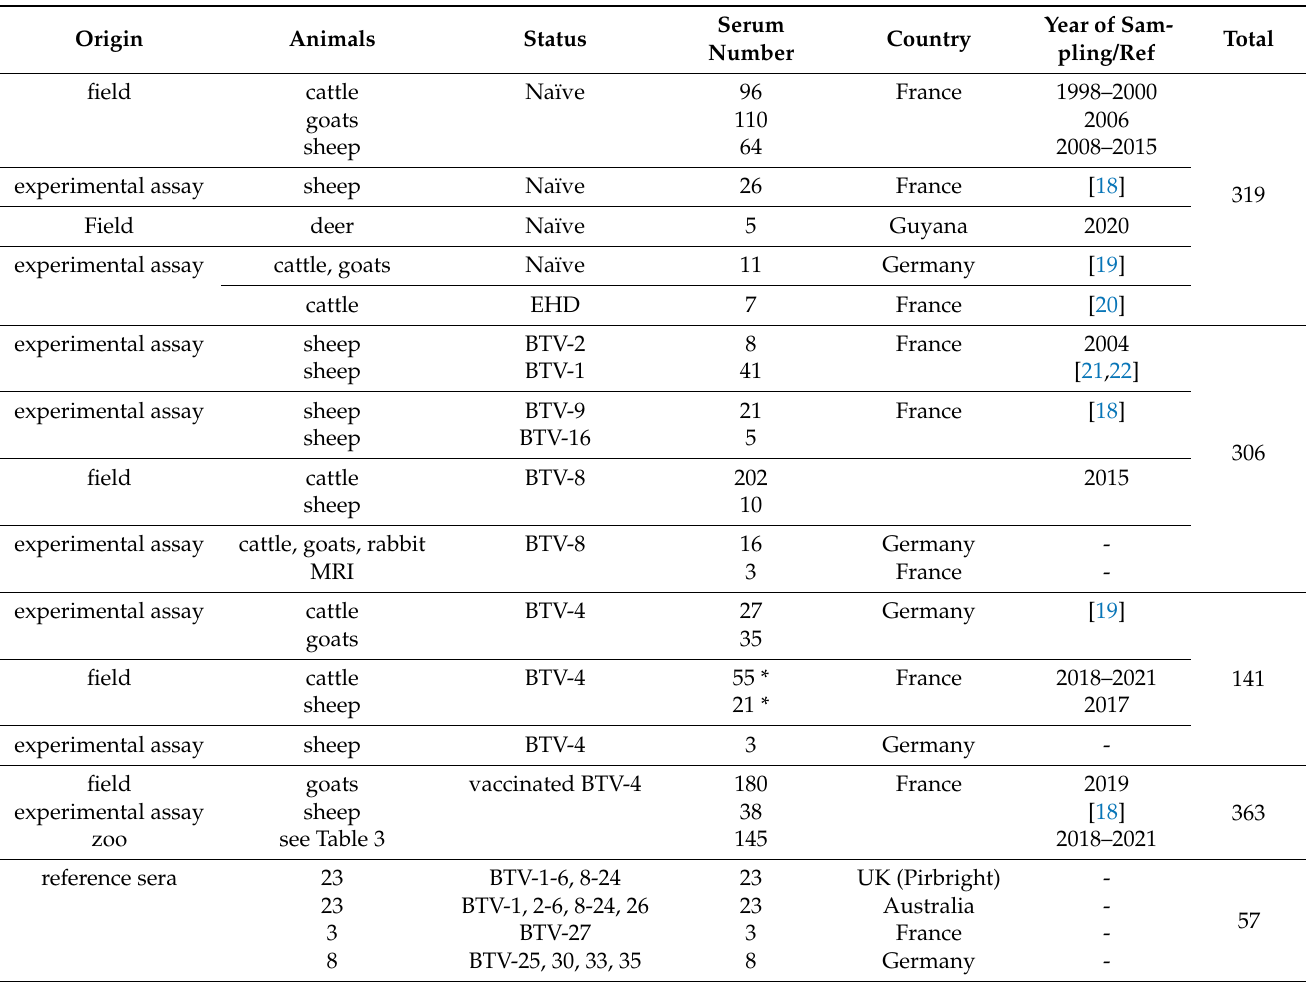
Table 1. Origin, status of the animals and year of sampling/article references. IRM: Internal Reference Material for ELISA.